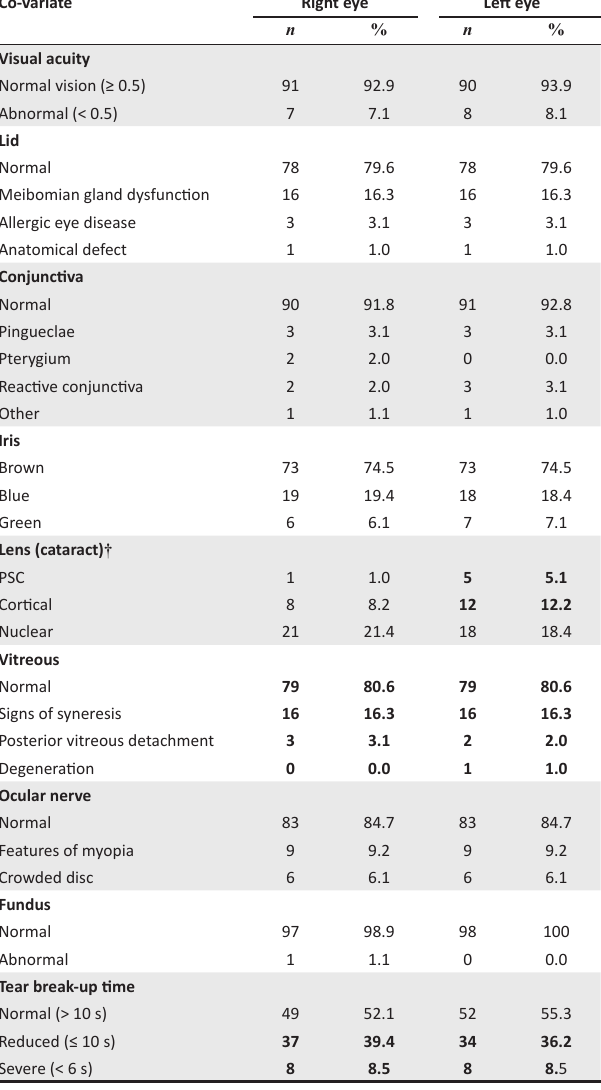
TABLE 3: Ophthalmological findings in the 98 interventionalists. Co-variate Right eye Left eye